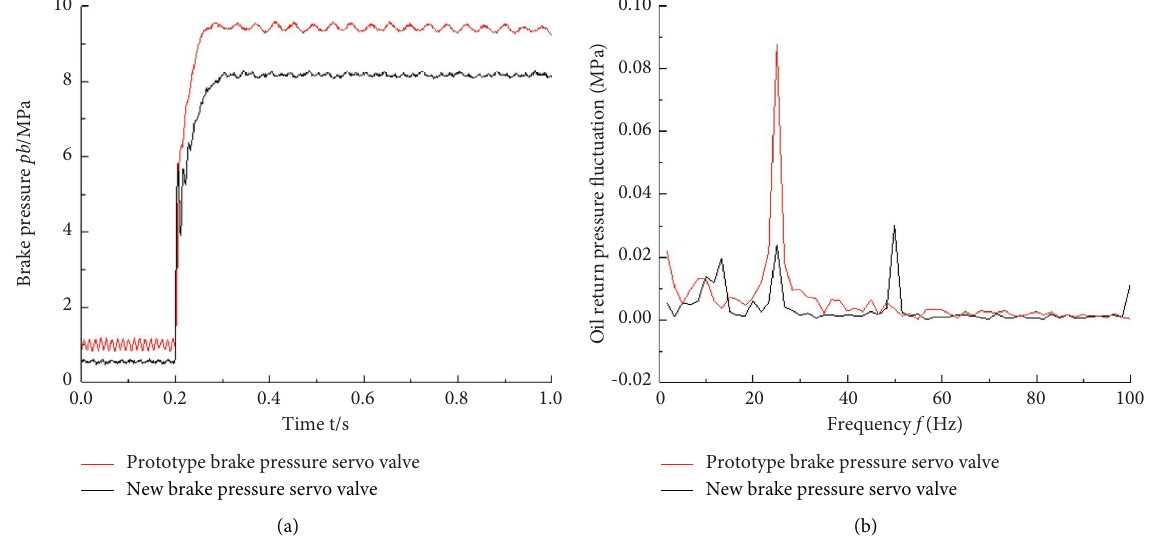
Figure 19: Comparison of experimental results of brake pressure. (a) Brake pressure time domain curve. (b) Brake pressure frequency domain